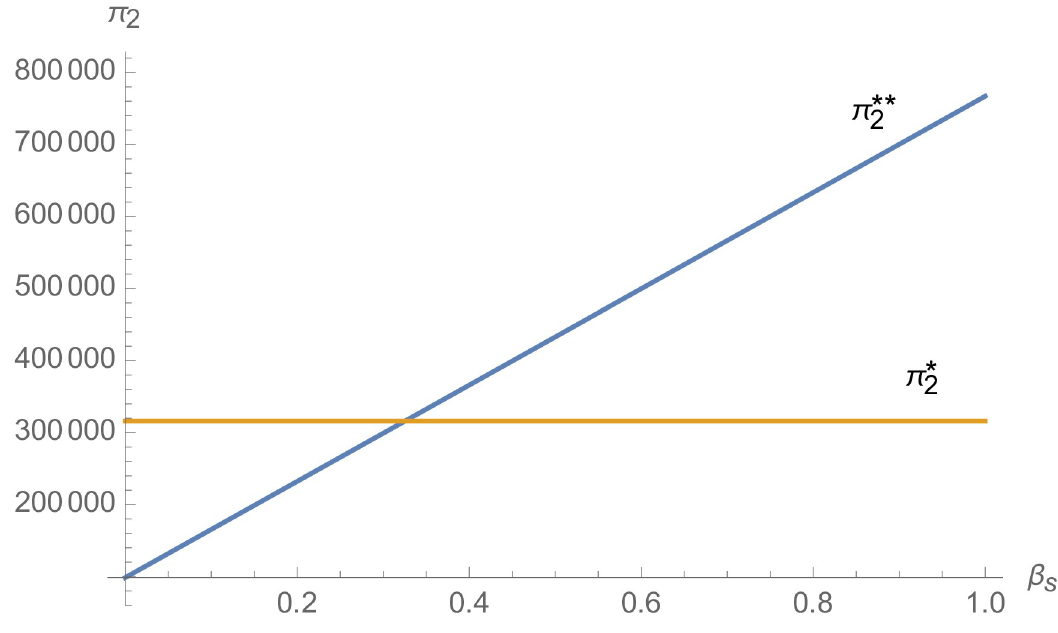
Fig 28. The impact of β